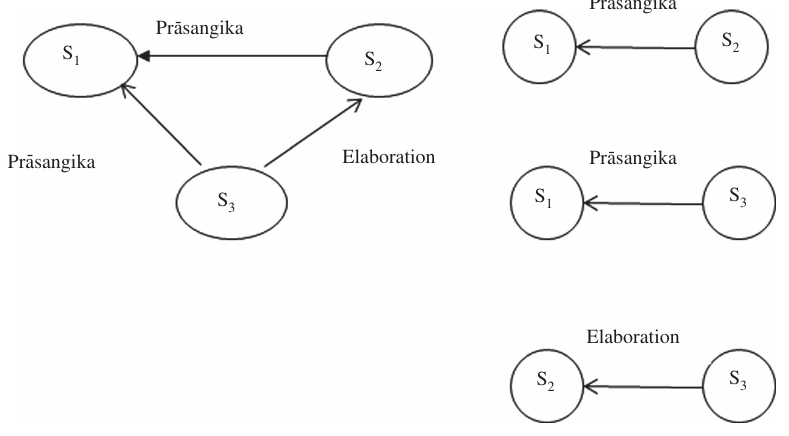
Figure 7. Patterns Identified for